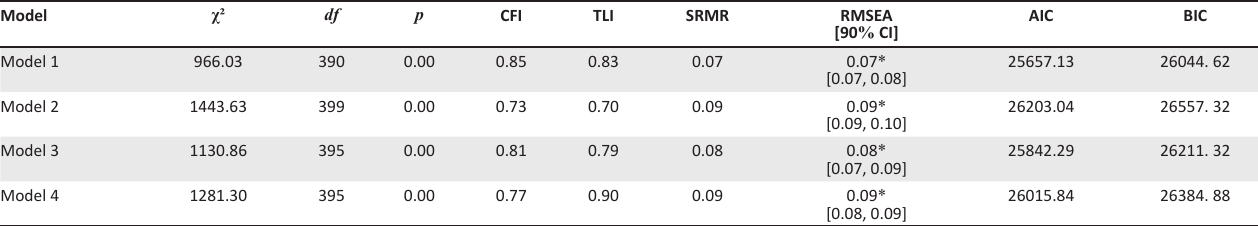
TABLE 1: Competing measurement